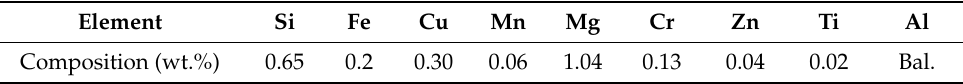
Table 2. The chemical composition of the A6061-T6 base material (BM).